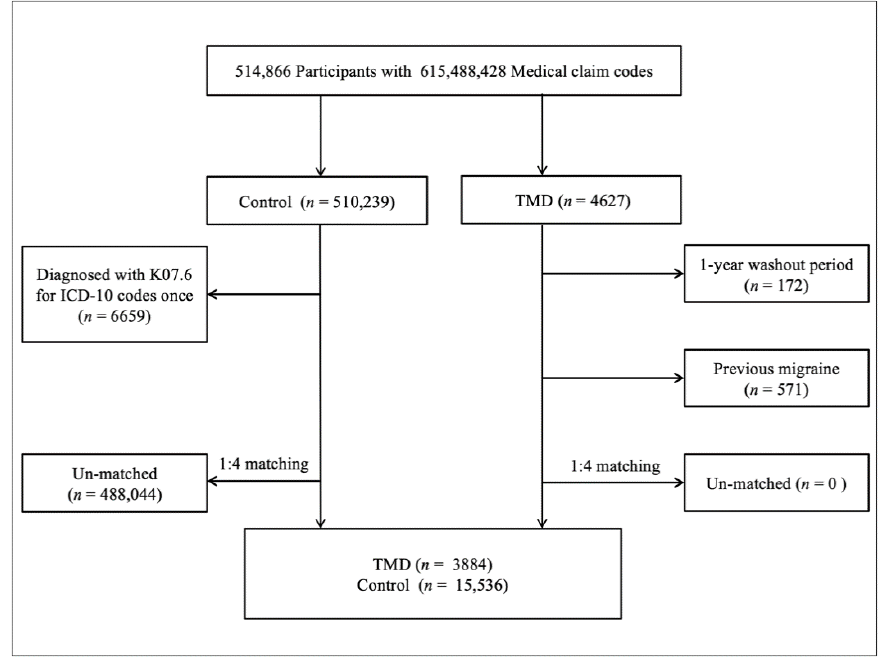
Figure 1. A schematic illustration of the participant selection process. Out of 514,866 participants, 3884 patients with temporomandibular disorder were matched at a 1:4 ratio with 15,536 control participants for age, sex, income, and region of residence. TMD, temporomandibular disorder; ICD-10, International Classification of Diseases, 10th edition.